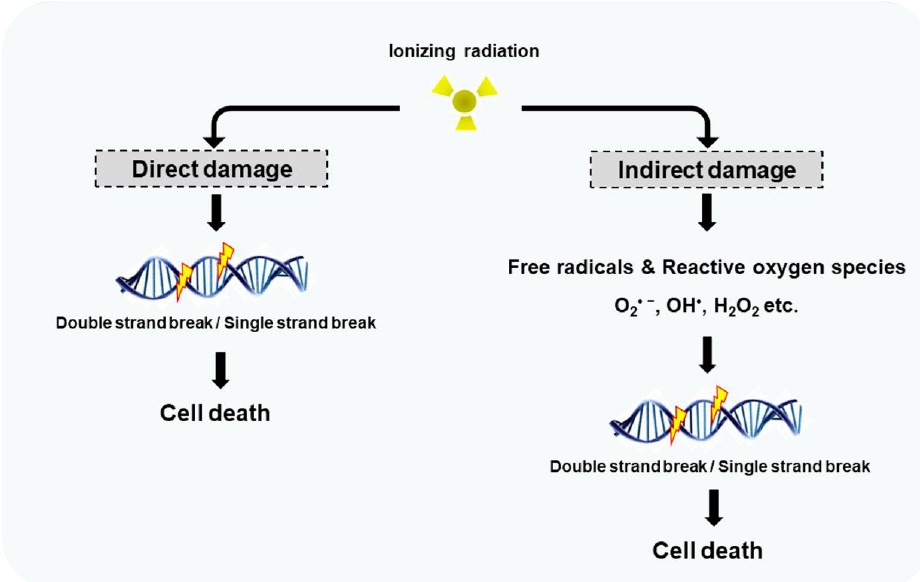
Figure 1. Ionizing radiation damages the DNA by direct and indirect effects. Direct damages arises from direct interaction between radiation and cellular DNA. Indirect DNA damage is caused by free radicals prevenient of the radiolysis of water molecules present in the cells. Reproduced from Hur and Yoon, MDPI, 2017 [26].